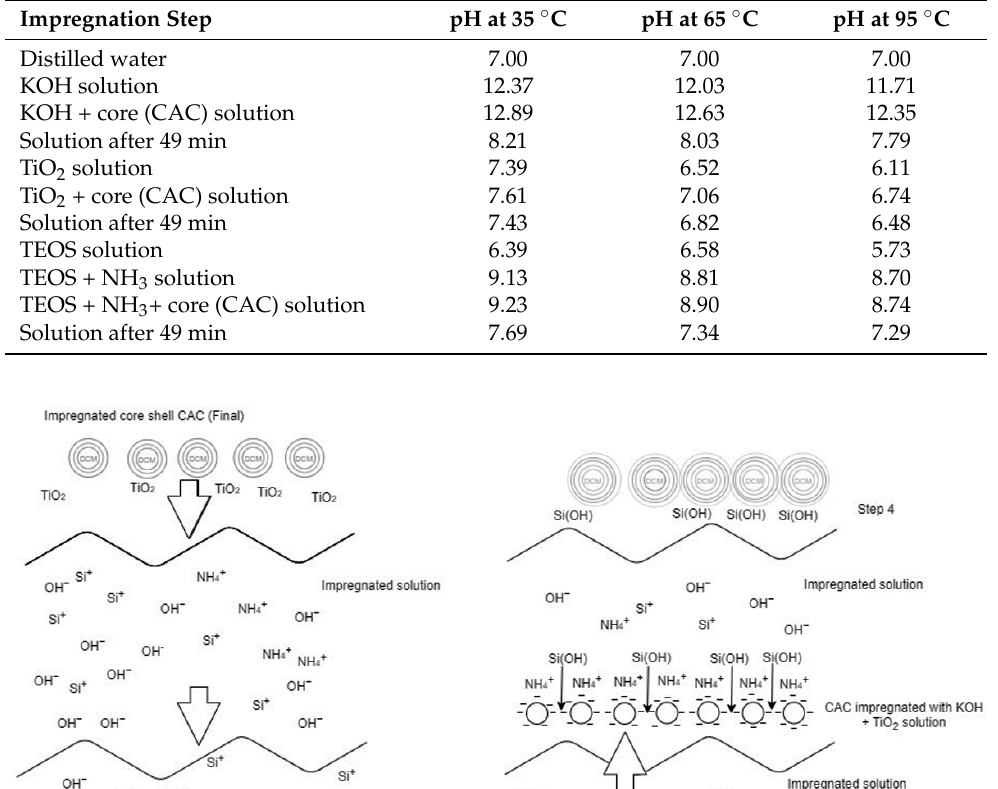
Table 2. pH value in each impregnation step of ZnAc 2 /ZnO/CAC_OS at different soaking temperatures.